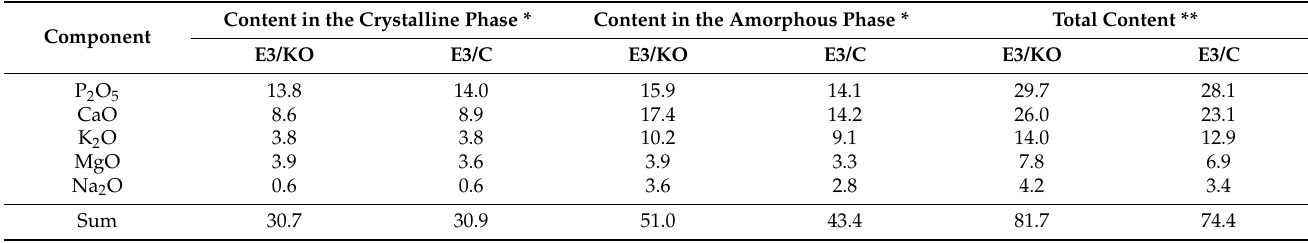
Table 8. Distribution of the main elements between the crystalline and amorphous phases (% wt.) of ashes obtained from the combustion of poultry manure (experiment E3).